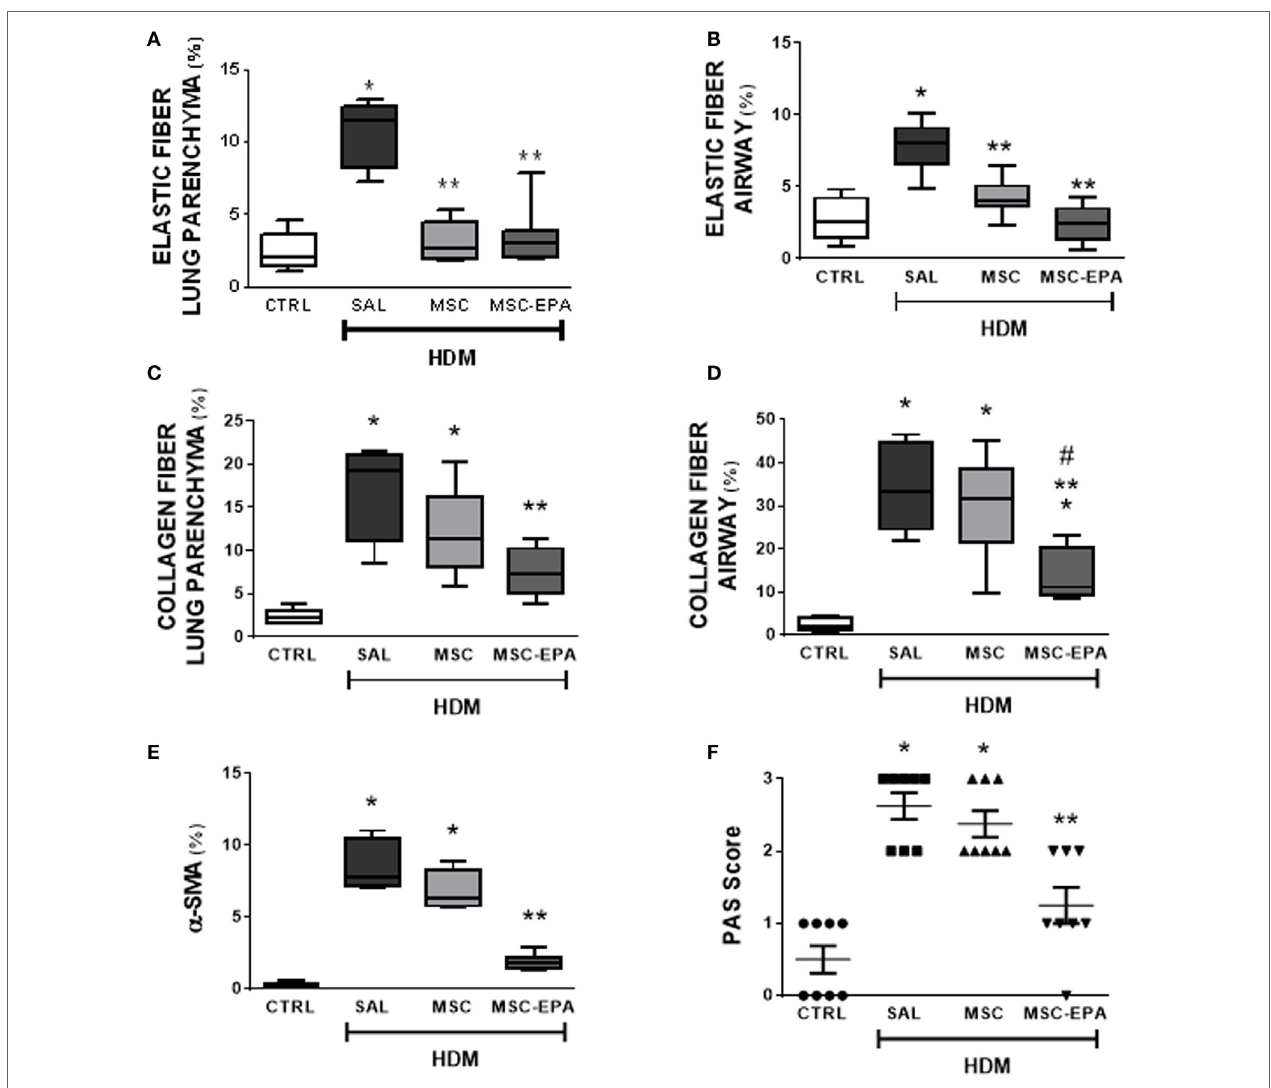
FigUre 5 | EPA-stimulated MSCs led to greater reductions in lung remodeling and mucus hypersecretion than unstimulated MSCs. Elastic fiber content in (a) lung parenchyma and (B) airway, collagen fiber content in (c) lung parenchyma and (D) airway, (e) α -SMA expression, and (F) mucus-filled cell count in lung tissue. CTRL, saline-challenged mice; HDM, HDM-challenged mice; SAL, HDM mice treated with saline; MSC, HDM mice treated with unstimulated MSCs; MSC-EPA, HDM mice treated with EPA-stimulated MSCs. The Kruskal–Wallis test followed by Dunn’s test was used for statistical comparison. Boxes show the interquartile (25–75%) range, whiskers denote the range (minimum–maximum), and horizontal lines represent the median of eight animals/group. *Significantly different from CTRL ( p < 0.05). **Significantly different from HDM-SAL ( p < 0.05). # Significantly different from HDM-MSC ( p < 0.05). Abbreviations: EPA, eicosapentaenoic acid; MSCs, mesenchymal stromal cells; HDM, house dust mite; SMA, smooth muscle